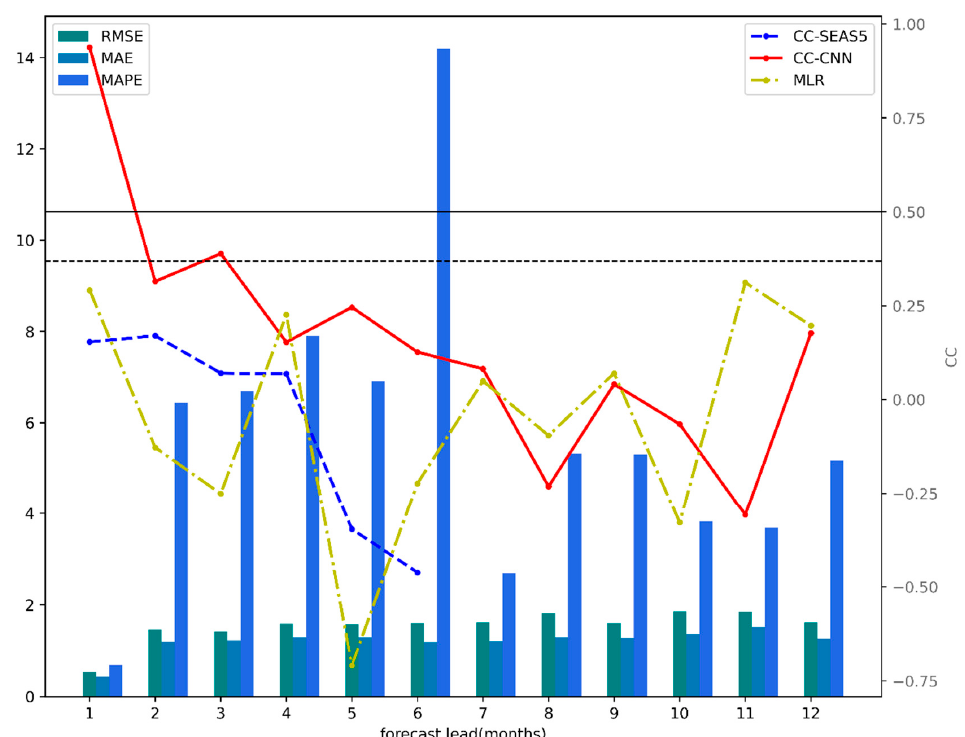
Figure 3. Correlation skills of the predicted NCDT from CNN (red solid line), SEAS5 (blue dotted line), and MLR (yellow dash-dotted line); RMSE (teal bar), MAE (dark blue bar), and MAPE (sapphire-blue bar) between the predicted NCDT from CNN and observation during 1995–2017. The correlation skills above the black solid (dotted) line are significant at the level of 0.01 (0.05).